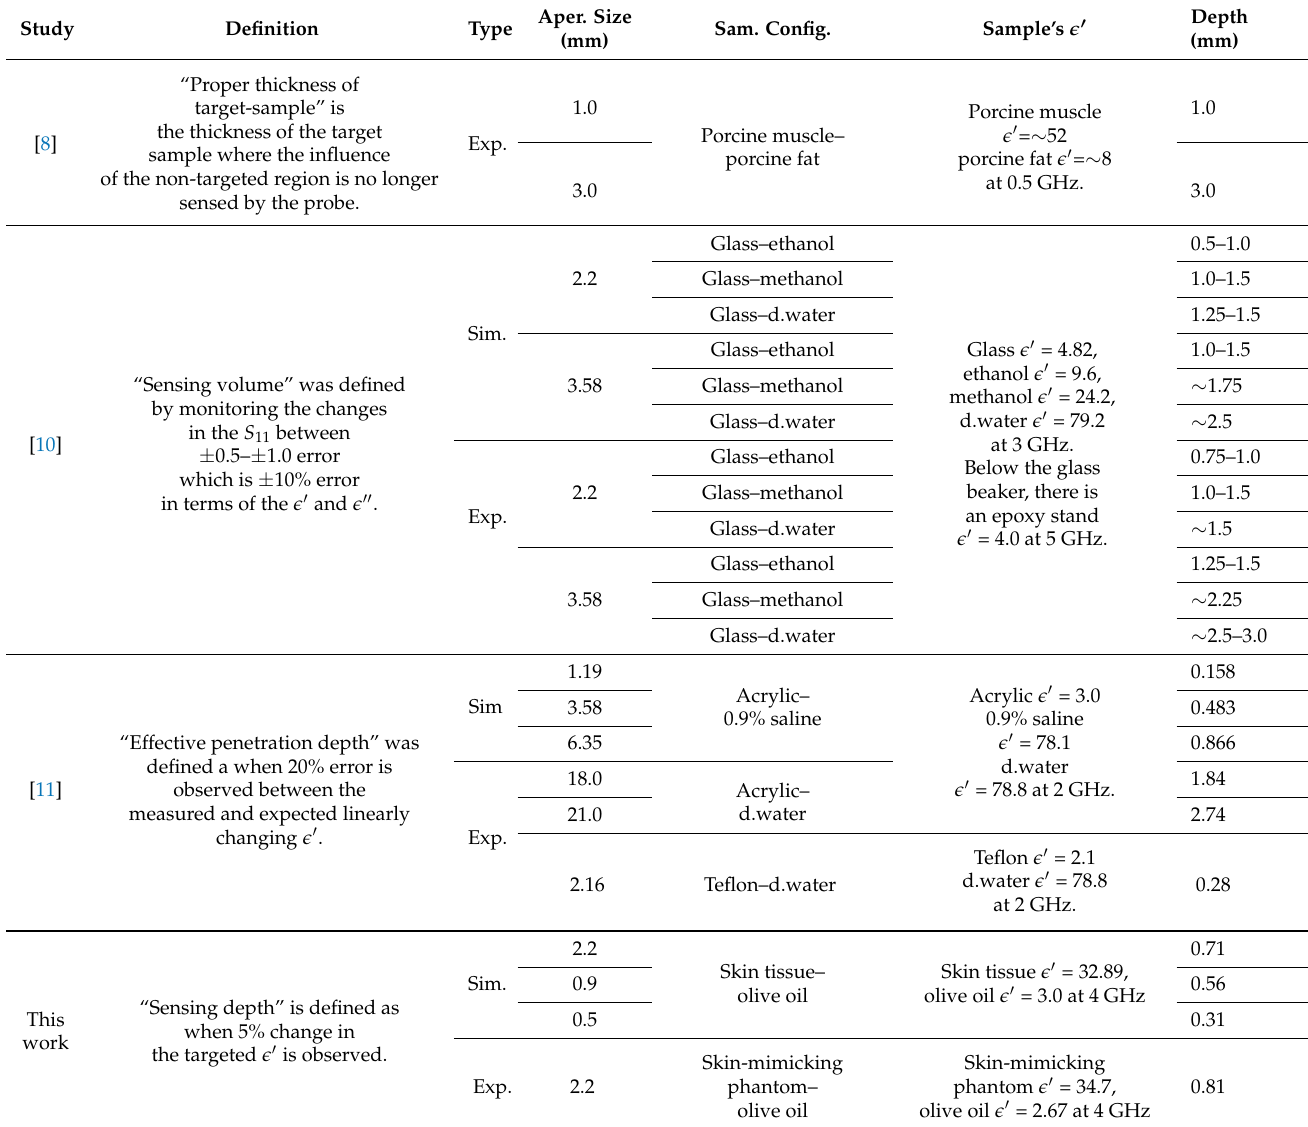
Table 8. List of literature studies on different aperture sizes, sample configurations and different terminologies to define the sensing depth of the OECP.